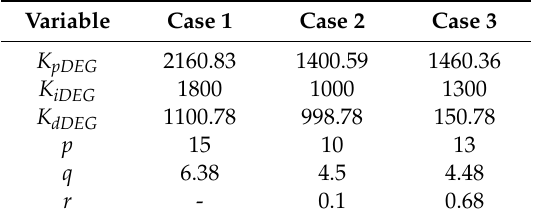
Table 6. Optimum PID controller parameters after leveraging the FPA.